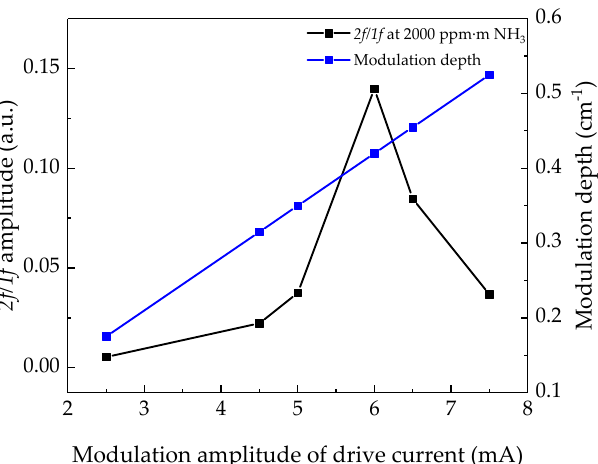
Figure 4. Modulation depth optimization performed at 2000 ppm · m NH 3 , the optimal modulation depth is 0.4199 cm − 1 with a modulation amplitude of drive current at 6 mA.